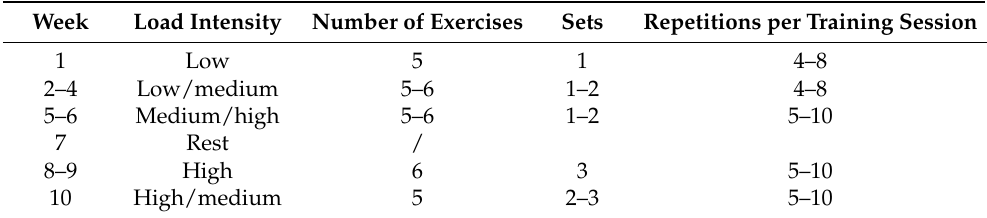
Table 1. Plyometric program dosing